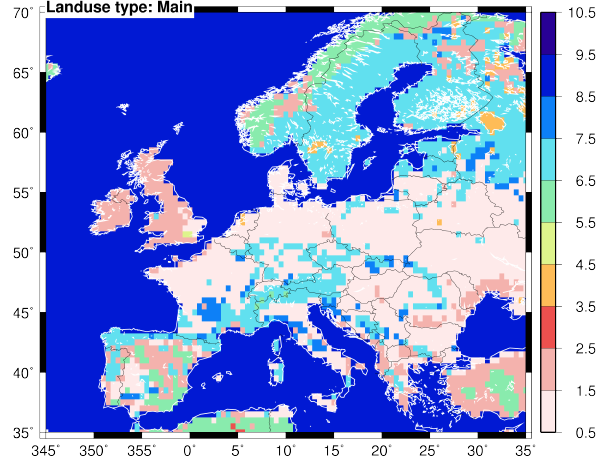
Fig. 5. Example of GLCF land use regridded over a CHIMERE domain: the western European domain used for the GEMS project with a horizontal resolution of 0.5 × 0.5 degrees. For each cell the dominant land use is shown. The colour code correspond to the land use number (with 1 between 0.5 and 1.5, for example). The codes are: (1) Agricultural land/crops, (2) grassland, (3) barren land, (4) inland water, (5) urban, (6) shrubs, (7) needleleaf forest, (8) broadleaf forest, (9) ocean.